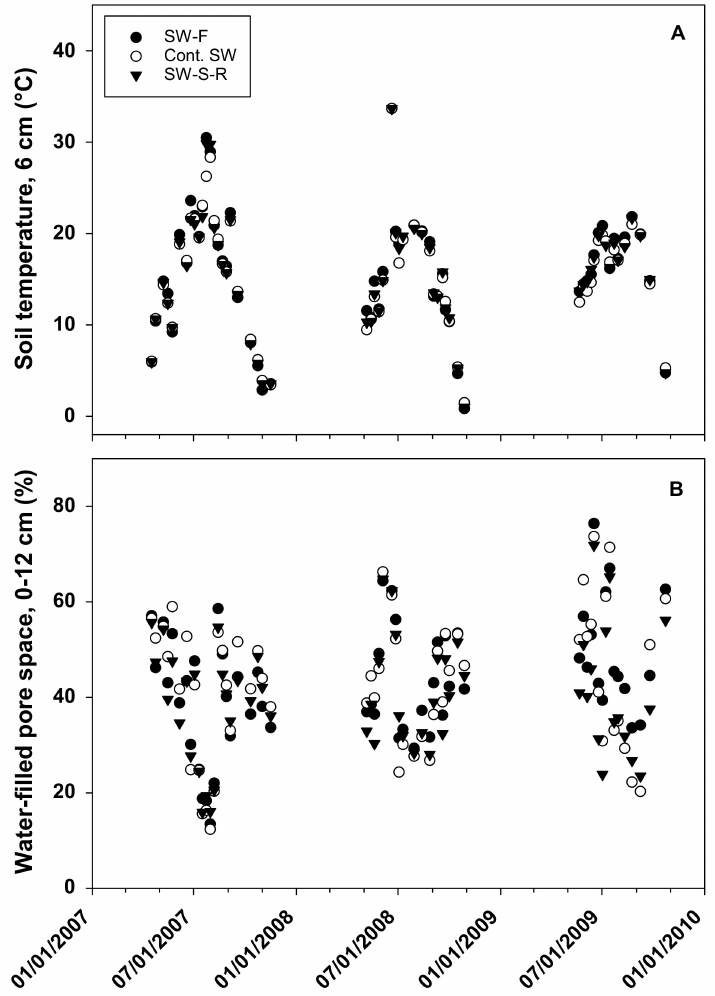
Figure 2. Near-surface soil temperature ( A ) and water-filled pore space ( B ) within spring wheat–fallow (SW-F), continuous spring wheat (Cont. SW) and spring wheat–safflower–rye (SW-S-R) cropping systems during unfrozen periods from April 2007 through October 2009. Mean values are reported across crop phases for SW-F and